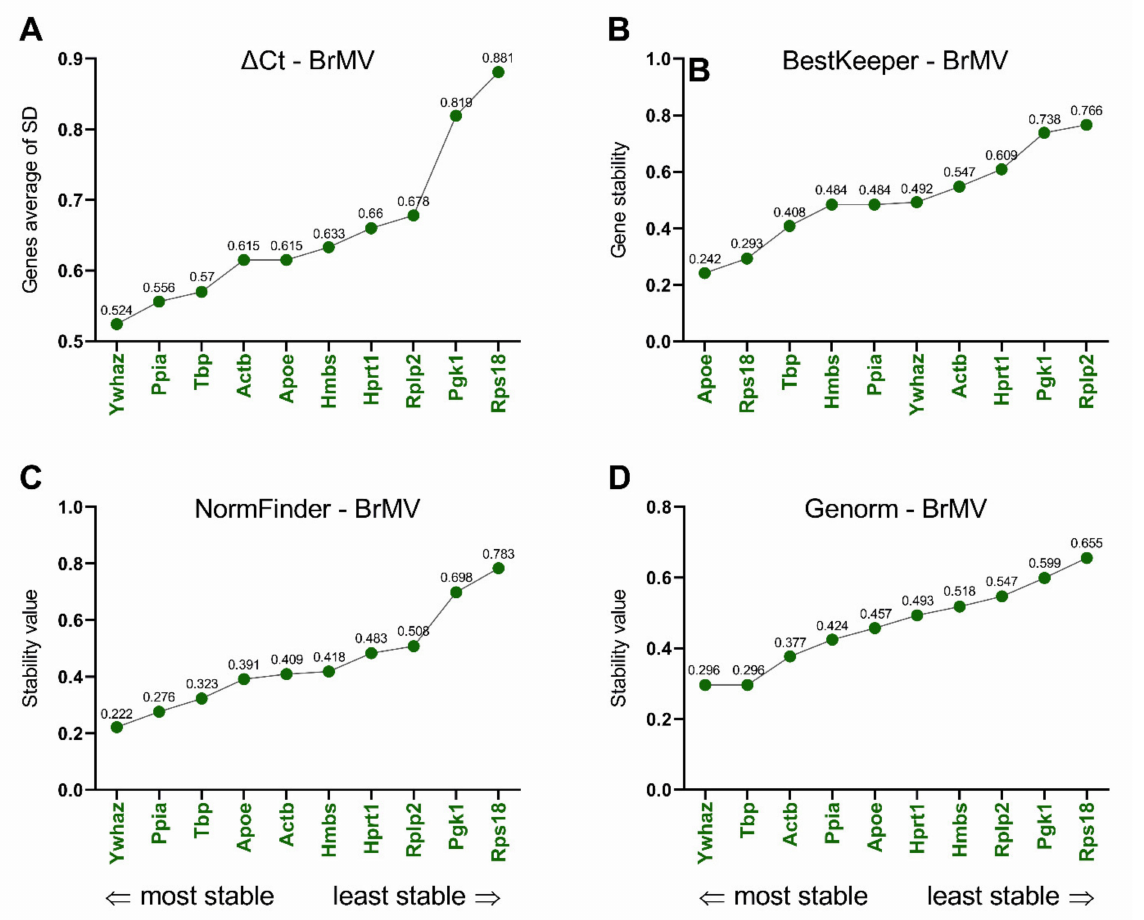
Figure 4. Expression stabilities and ranking of reference genes in rat brain microvessels (BrMV; n = 6, 6 females/3 samples and 6 males/3 samples for each time point) according to the ∆ Ct ( A ), BestKeeper ( B ), NormFinder ( C ), and Genorm ( D ) algorithms. Ranking calculated using